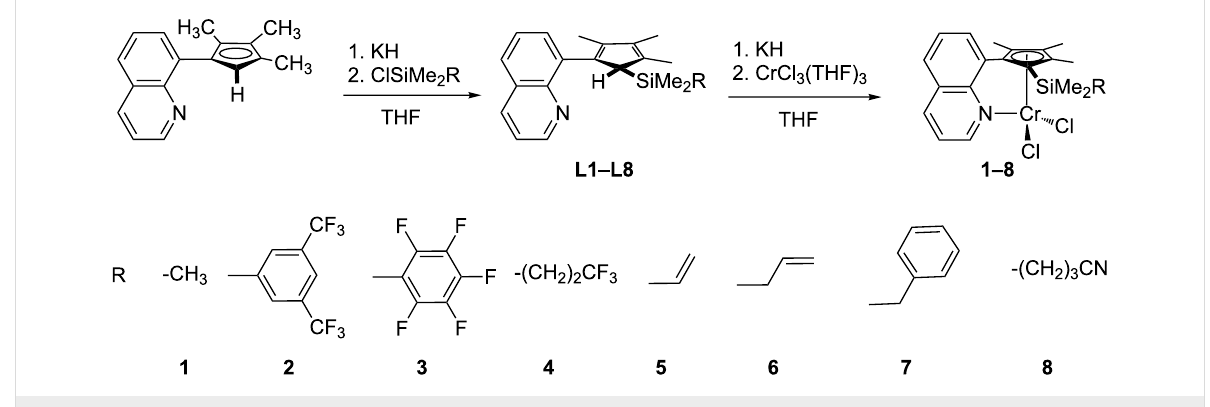
possible [15]. The experimental verification of such an interac- tion was demonstrated by NMR of an MAO activated complex [17]. Consequently, we envisaged the synthesis of ligands where an organofluorine substituent is connected by a side arm with suitable length. In addition to that we choose side arms with olefinic groups, a benzyl unit and a stronger nitrile donor group, respectively. The synthesis of the new ligand derivatives and the corresponding Cr complexes follows known procedures (Scheme 2) [29,58]. The key step for the introduction of the hemilabile donor function is the electrophilic attack of a chlorosilane derivative at quinolyl-functionalized cyclopentadi- enides (Cp Q ). We used the trimethyl Cp Q derivative as this leads to a single acidic proton in the ligands L1 – L8 . By this procedure we could introduce side arms with fluorine ( L2 – L4 ) or olefinic donor groups ( L5 , L6 ) as well as benzyl ( L7 ) or nitrile ( L8 ) moieties. Deprotonation with potassium hydride and subsequent reaction with chromium trichloride leads to the chromium complexes as green-blue solids in yields ranging from 21% ( 3 ) to 81% ( 6